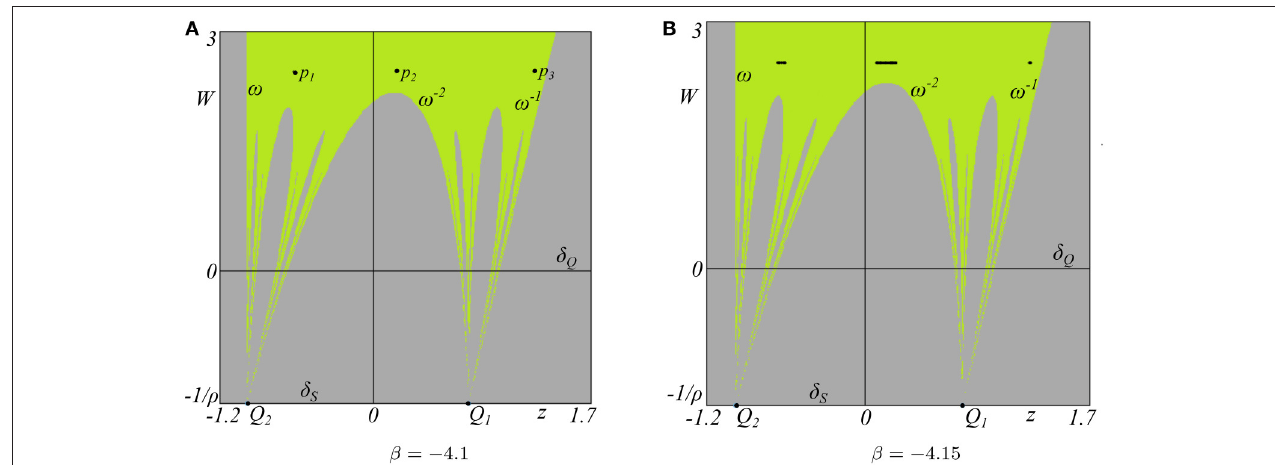
FIGURE 8 | Phase space ( z , W ) of the map T and relative basins of attraction. In (A) the green basin denotes convergence to the 3-cycle while in (B) the green region refers to convergence to the chaotic attractor. Other parameter values are ρ